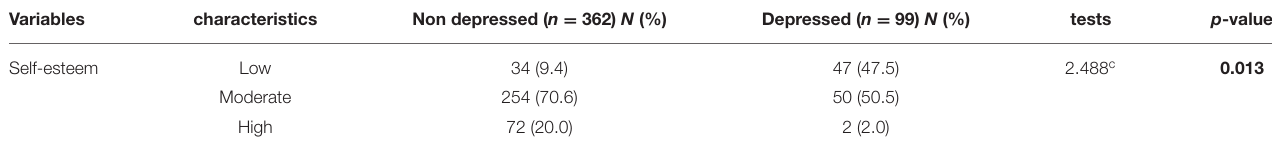
TABLE 2 | Association between self-esteem and adolescent depression.